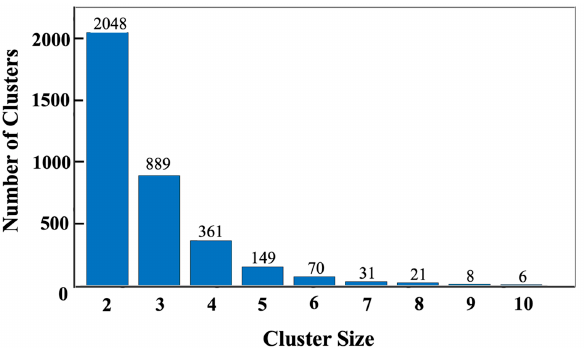
Figure 12. The cluster sizes (in terms of the number of single particles contained in the cluster) and their corresponding numbers after 7 million iterations. Materials 2023 , 16 , x FOR PEER REVIEW Figure 13 illustrates the pore size distribution. The pore size contains nano porous regions from 1 to 5 nm, and the most available distribution of pores is at 1.4 nm, with 1.05,